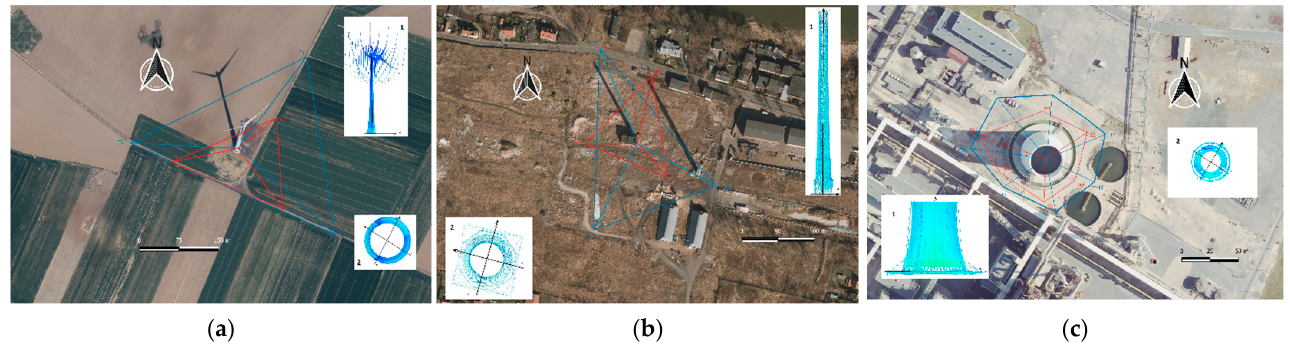
Figure 2. Positions of the measurement locations around the objects together with the local coordinate system: ( a ) cooling tower, ( b ) smokestack, ( c ) wind turbine tower. (1) Scan of the object—side view, (2) local coordinate system–top view. Blue lines–control network, observation range, and total station positions; red lines–control network, observation range, and laser positions. Image in the background—orthophotomap from the Geoportal web service (https://mapy.geoportal.gov.pl/ access 15 November 2021).